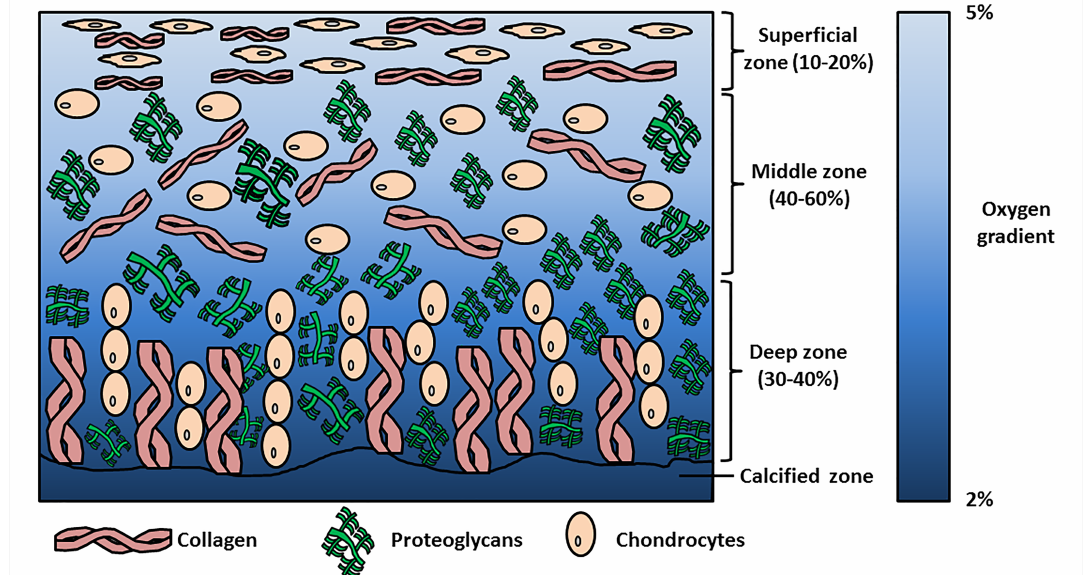
Figure 1. Schematic diagram describing the zones within articular cartilage and the changes in oxygen tension from the superficial zone to calcified